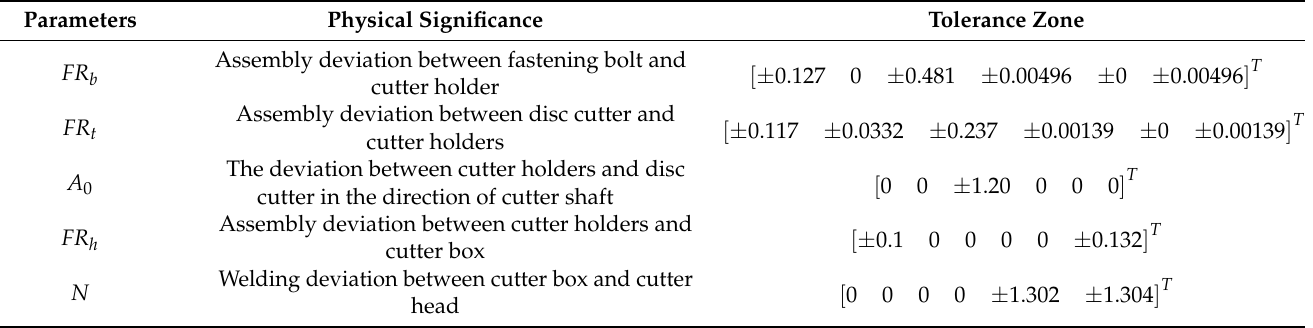
Table 2. Jacobian–Torsor models of the deviation of each part of the new integrated disc cutter